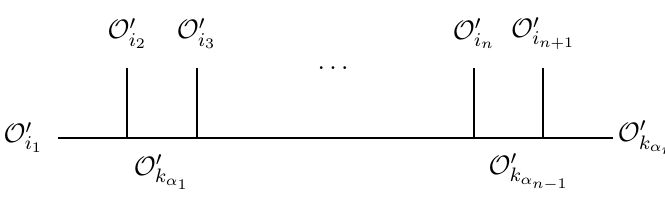
( x ) with i = 2 , 3 are internal operators, ≡ O 0 i a a 6 i a i a